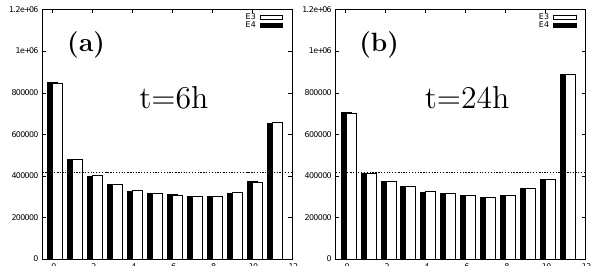
Fig. 5. Same as Fig. 3 for E3 (white) and E4 (black), at forecast ranges of (a) 6 and (b)